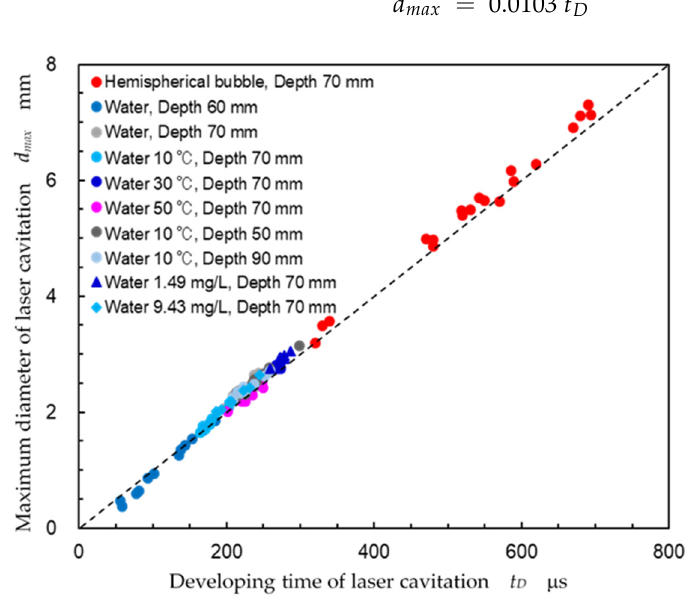
Figure 4. Relationship between the developing time t D and the maximum diameter d max of LC.